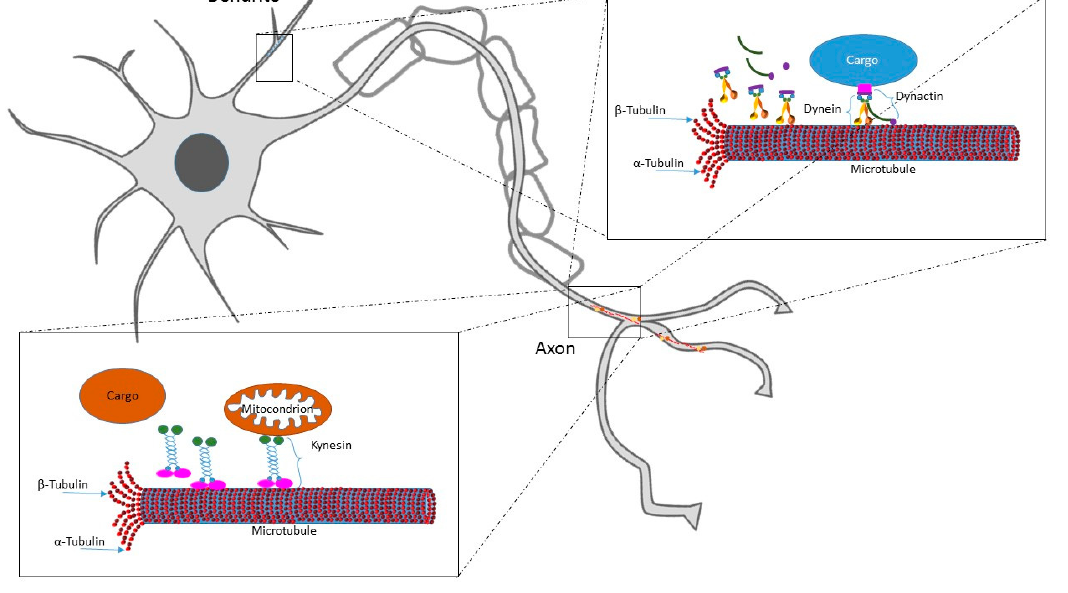
Figure 1. Scheme of MTs dynamics and trafficking.